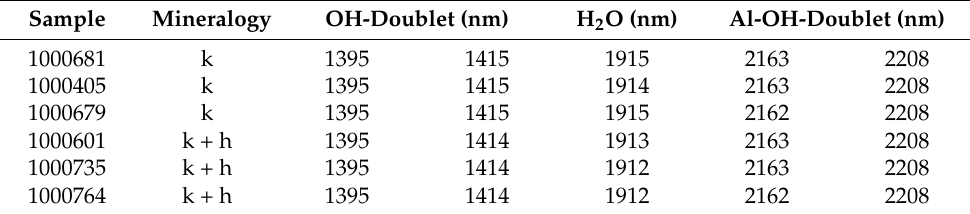
Figure 6. ( a ) Extracts of representative FTIR spectra from the project for samples 1000405 (98 wt.% kaolinite) and 1000764 (51 wt.% kaolinite, 44 wt.% halloysite). Note the differences in the H 2 O intensities and OH-doublets. The inset illustrates the OH stretching band intensity ratio (c.f. [31]); ( b ) reference spectra from the USGS spectral library [42], for kaolinite (splib07a rec = 6043) and halloysite (splib07a rec = 4695). Table 1. List of the absorption feature positions of assigned bands of pure kaolinite samples (k) and mixtures of kaolinite and halloysite with up to 44 wt.% halloysite (k +